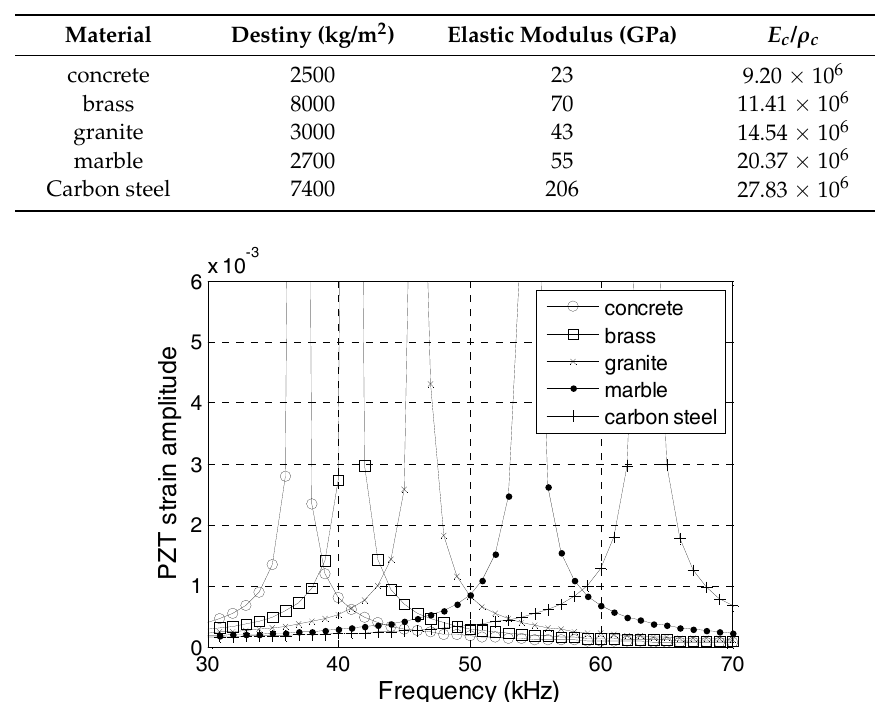
Table 2. Parameters of different protecting layer materials.